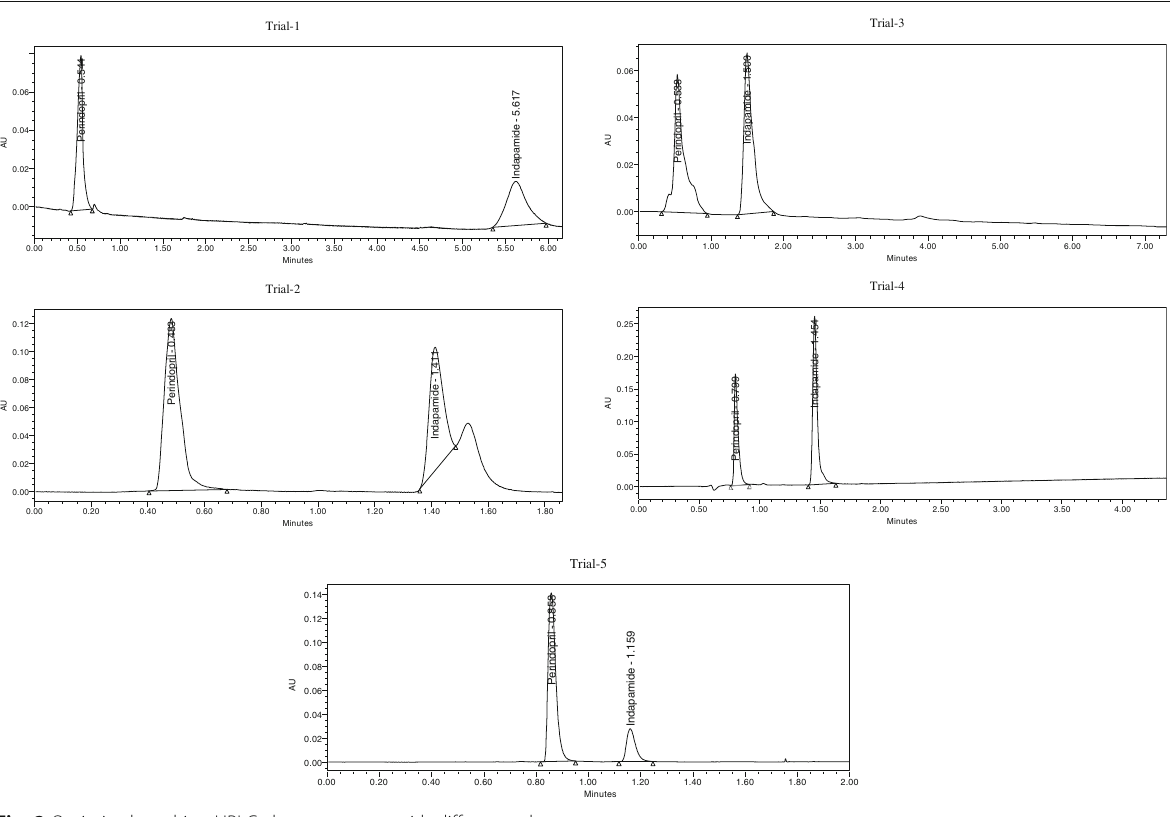
Fig. 2 Optimized resulting UPLC chromatograms with different